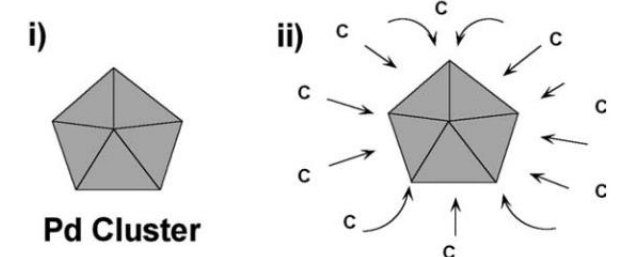
Figure 3. Schematic illustration of the typical chemical vapor deposition growth mechanism of the cup-stacked CNFs